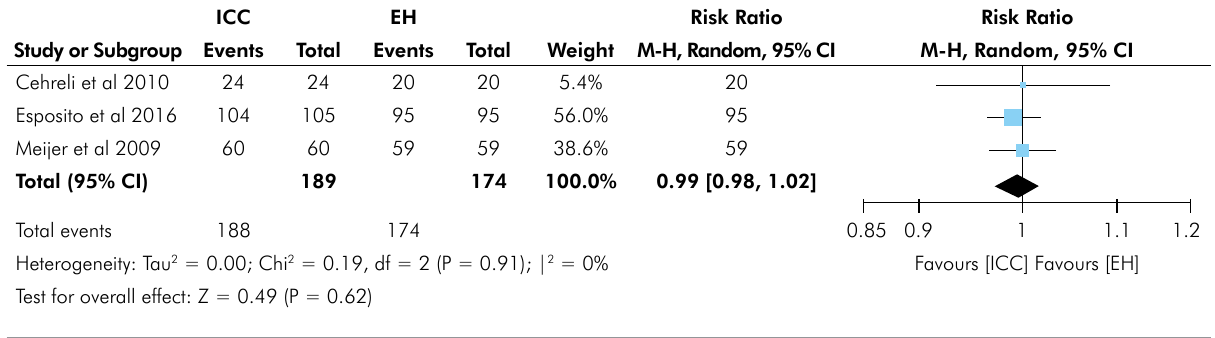
Figure 8. Implant survival rates after 5 years.